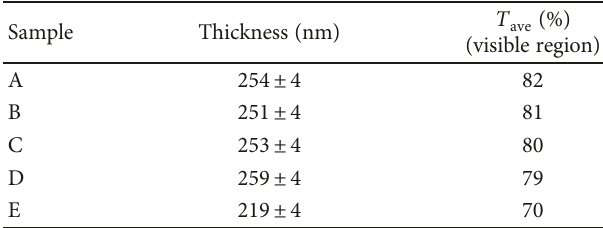
Table 3: Thickness and average transmission values of the as-deposited (sample A) and annealed CdS thin fi lms (samples B, C, D, and